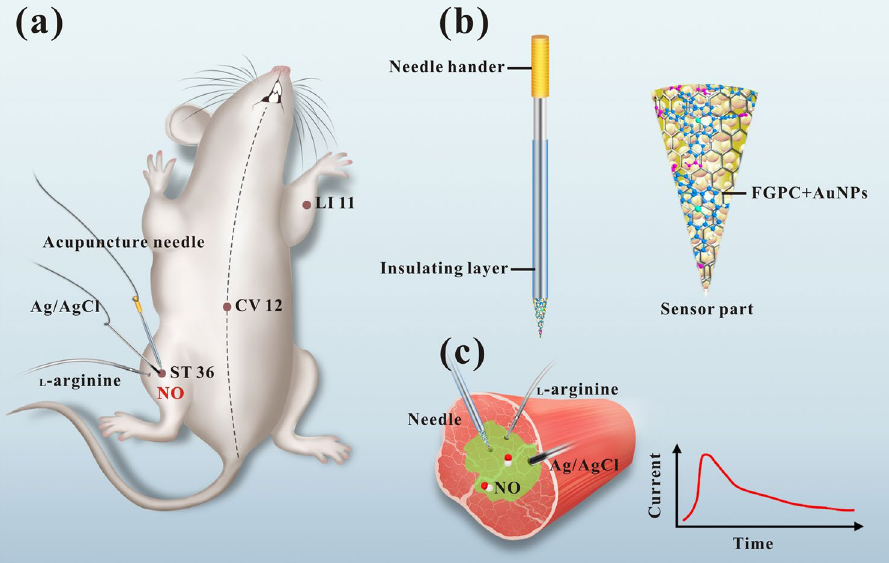
Figure 1. ( a ) Schematic illustration of a sensitive acupuncture needle microsensor for real-time monitoring of NO in acupoints of rats. ( b ) Schematic diagram of the FGPC/AuNPs/acupuncture needle. ( c ) Schematic diagram of real-time NO measurement in acupoint ST 36 stimulated by L